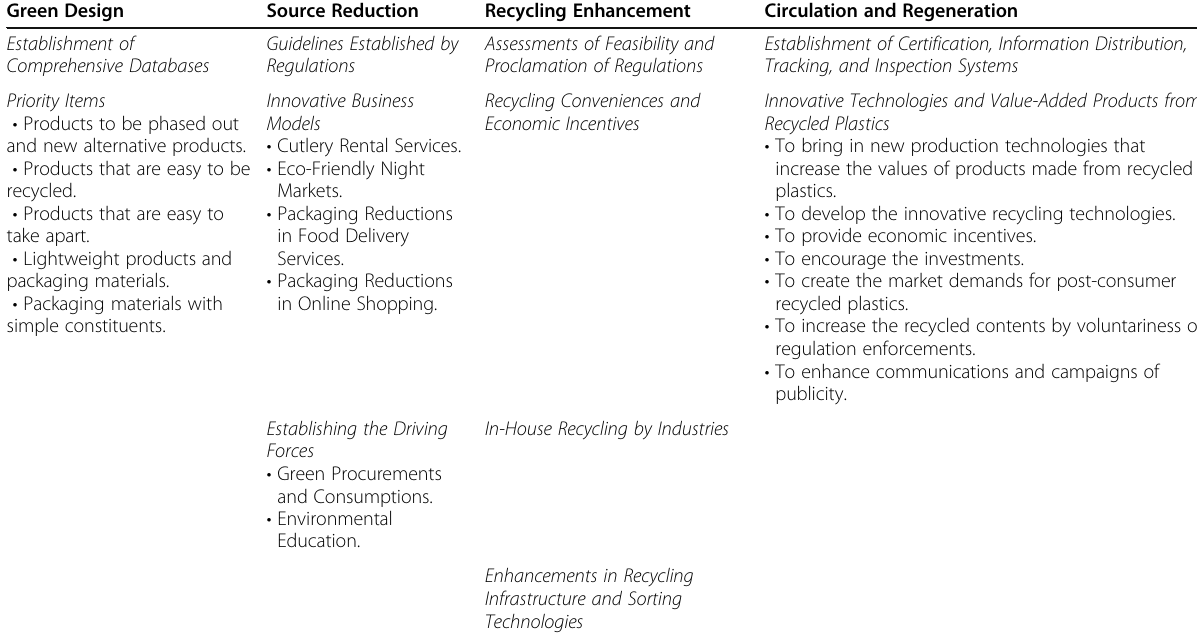
Table 4 Action plans pertinent to the recycling and reuse of plastics in Taiwan [14, 32] Green Design